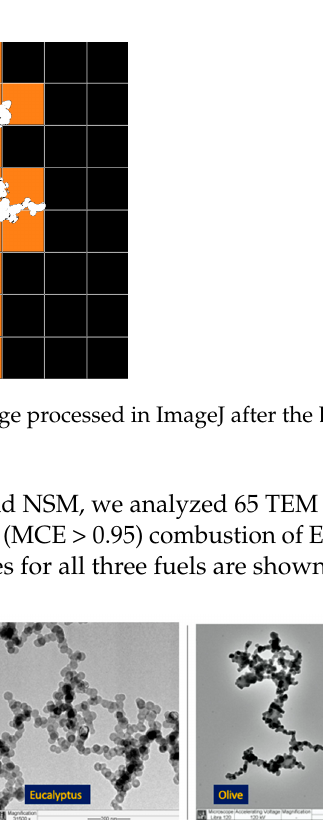
Table 1. The average 2D fractal dimensions calculated using BGM and NSM and the 3D fractal dimensions derived using Equations (3) and (4). (Errors are ± 1 σ .).